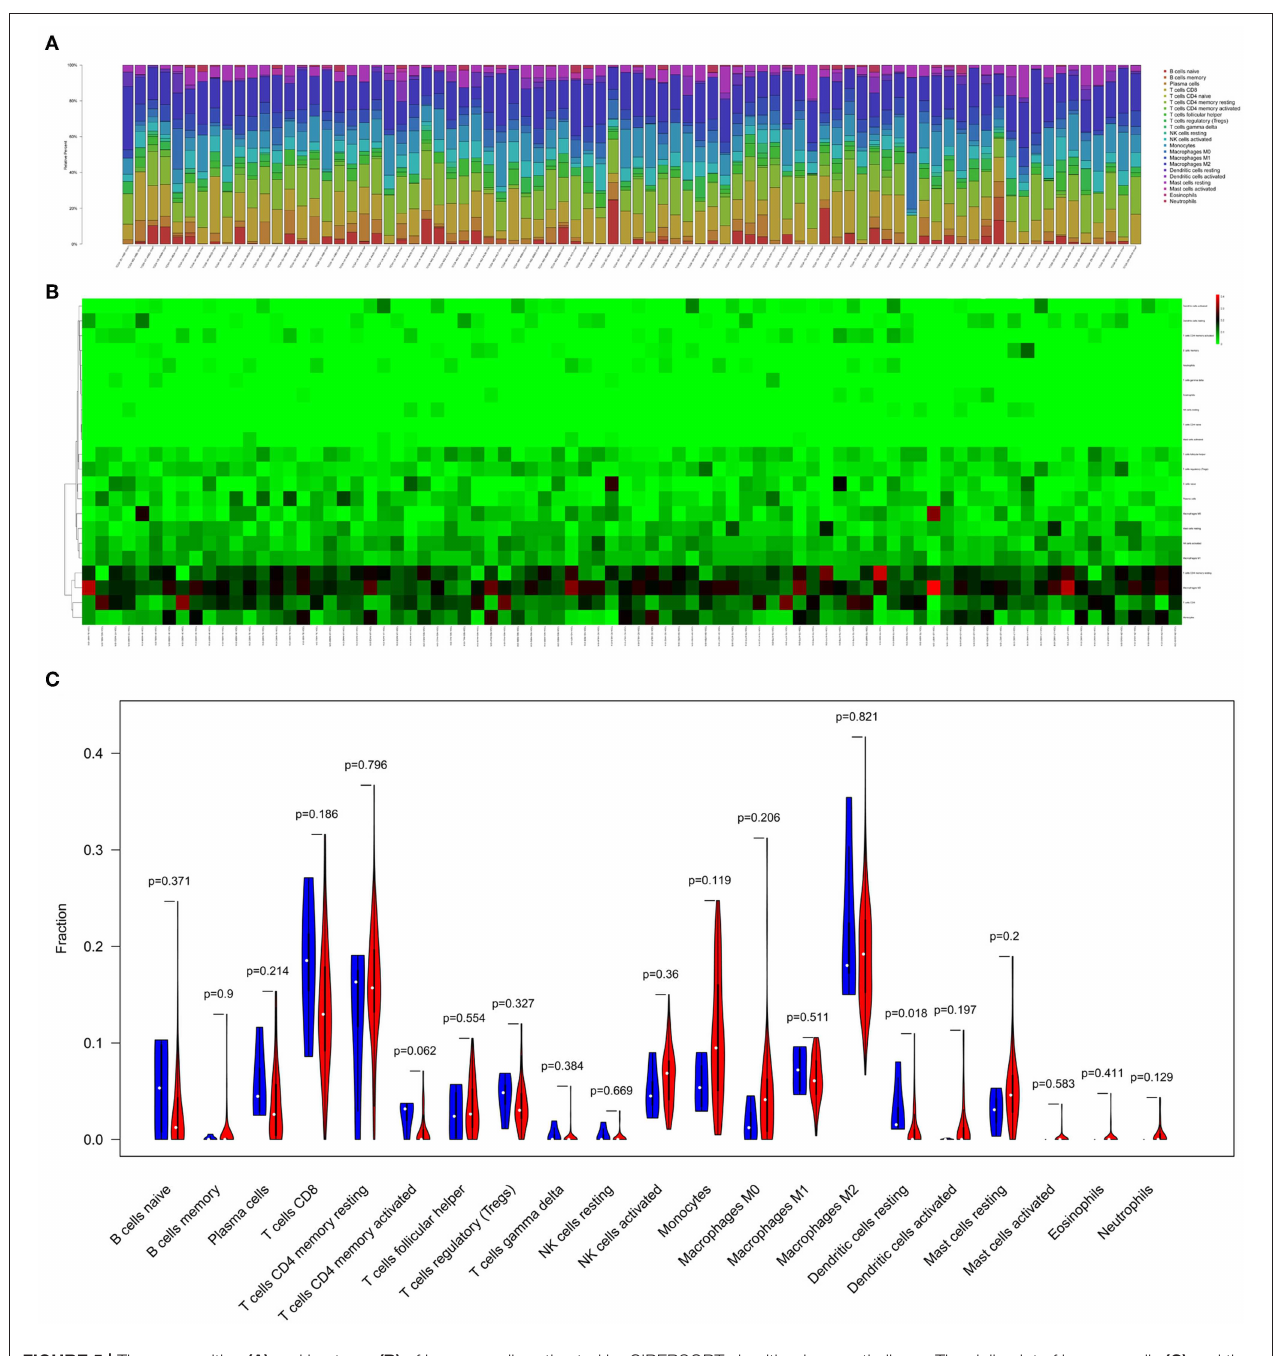
FIGURE 5 | The composition (A) and heatmap (B) of immune cells estimated by CIBERSORT algorithm in mesothelioma. The violin plot of immune cells (C) and the blue and red bar represent recurrent the tumor group and primary tumor group, respectively.